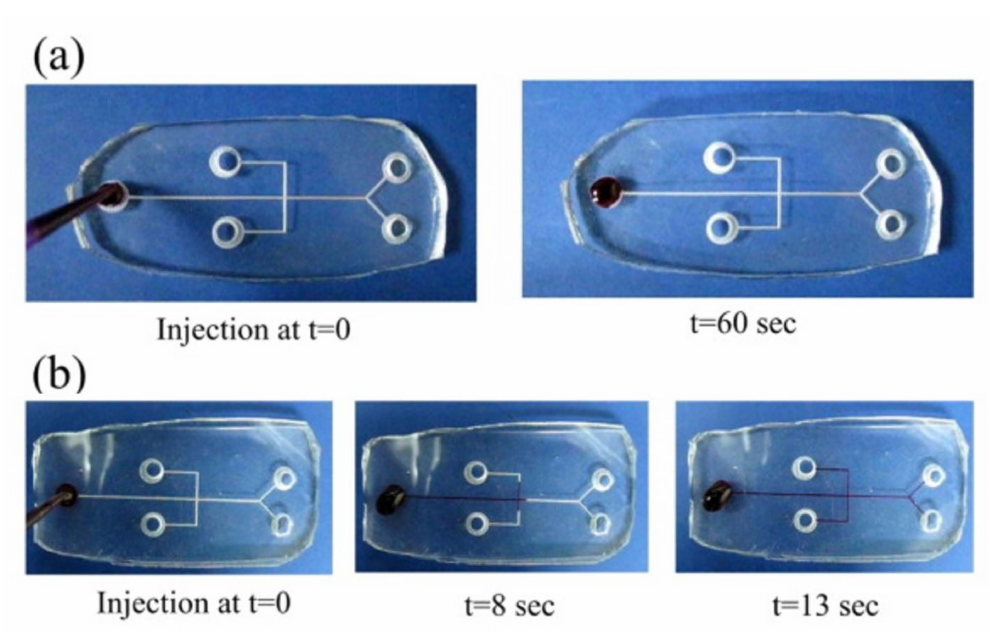
Figure 12. The capillary flow test with injection of Rhodamine B dye into the PDMS microchip: ( a ) 2 h after O 2 treatment, and ( b ) 420 h after O 2 -plasma-PEG treatment. The former shows no capillary flow of dye into the microchannel after 60 s while the latter exhibits the capillary flow of dye to half of full channel after 8 s, and through the microchannel after 13